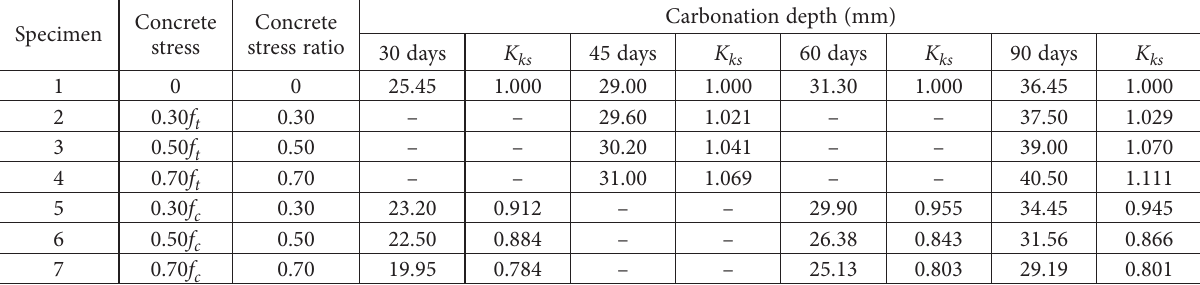
Table 1. Carbonation depths of specimens under different concrete stress conditions (data from Zhang, 2001) Concrete Specimen